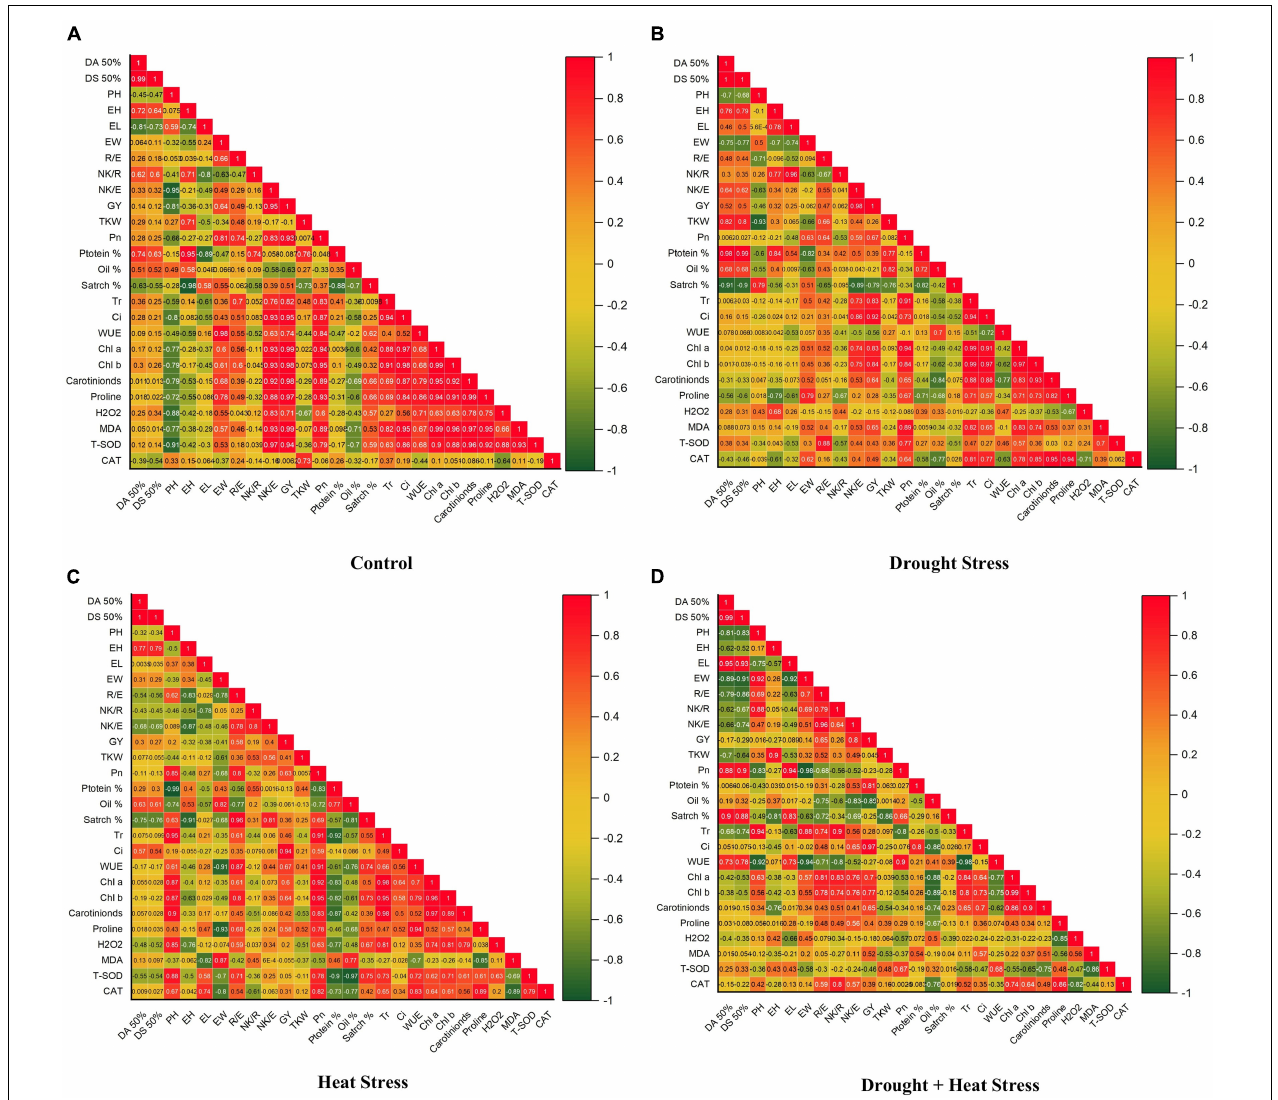
FIGURE 3 | Correlation coefficient graphs of morpho-physiological, biochemical, and stress-related parameters in five maize hybrids at the pre-anthesis stage under (A) control (B) drought stress (C) heat Stress (D) heat + drought